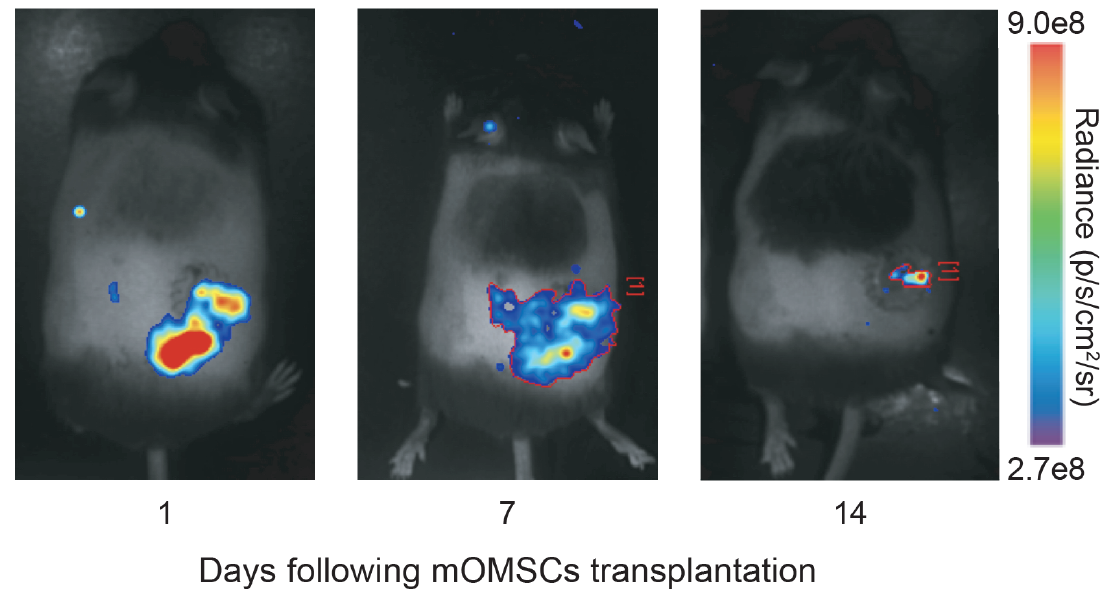
Figure 2. Luciferase-labeled mOMSCs remain viable in the wound area. In vivo bioluminescence imaging of mice 1, 7, and 14 days following administration of Luciferase-labeled mOMSCs to the wound. In this assay, only viable cells express luciferase, which emits light following chemical conversion of luciferin, allowing monitoring of the viability, location, and concentration of the luciferase-labeled cells.